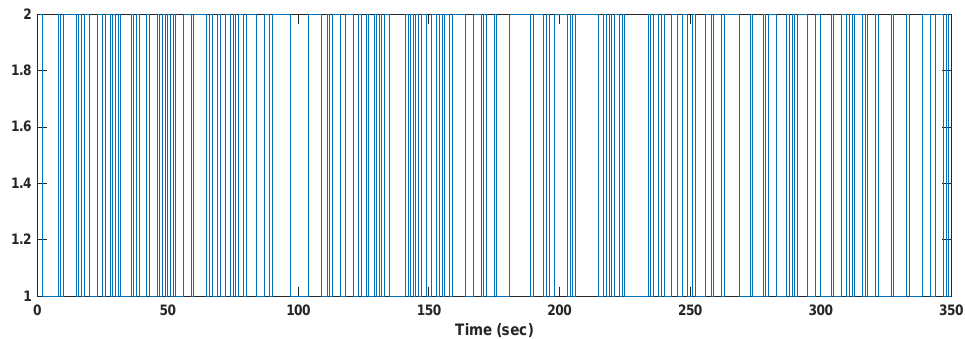
Figure 4. Example 2: Markovian changes.